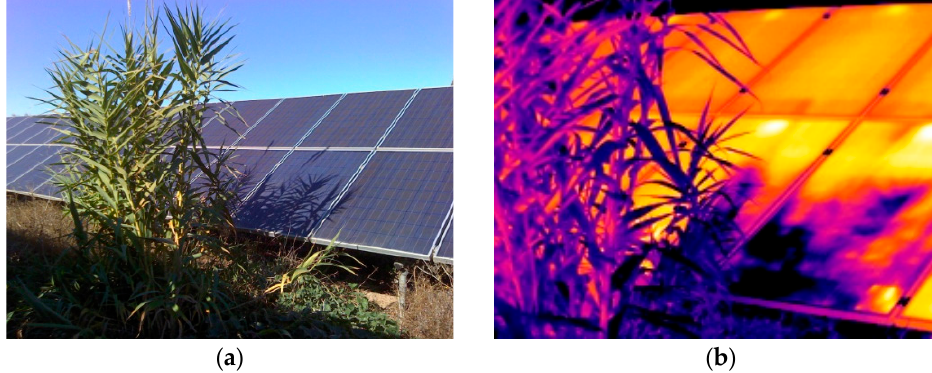
Figure 8. Ground-level thermographic analysis with an incident involving partial shading: ( a ) visual image, and ( b ) ground-level IR inspection.